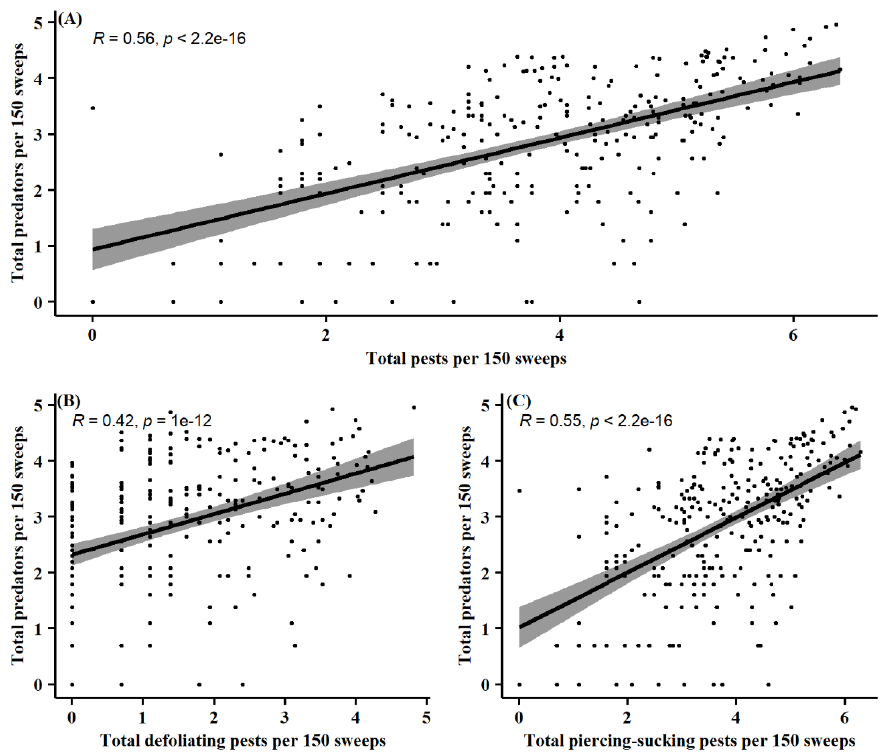
Figure 7. Pearson’s correlation coefficients comparing ( A ) per 150 sweeps, total predator abundance vs. total pest abundance, ( B ) total predator abundance vs. total defoliating pest abundance, and ( C ) total predator abundance vs. total piercing-sucking pest abundance. Data points represent each site, MG, growth stage, and year combination across the entire sampling period (2012–2018). Data point values are log(x + 1) transformations. p < 0.05 indicates significant correlation between variables.